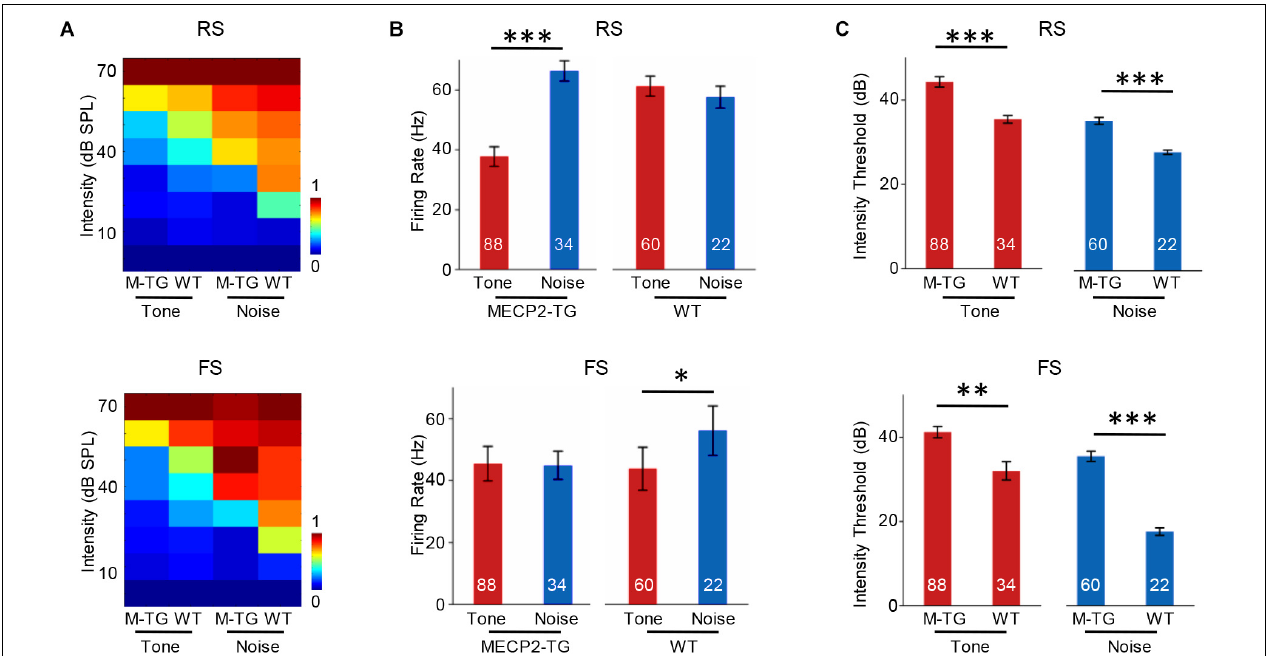
FIGURE 7 | (A) Average receptive fields of regular-spiking (RS) and fast-spiking (FS) neurons recorded from MECP2-TG and wild-type (WT) mice in response to a pure tone [7000 Hz, 70 dB sound pressure level (SPL)] and white noise (70 dB SPL). (B) Averaged activity of RS and FS neurons in response to a pure tone (7000 Hz, 70 dB SPL) and white noise (70 dB SPL) at 70 dB. ∗ p < 0.05, ∗∗∗ p < 0.001; paired t -test; mean ± SEM. (C) Average intensity threshold of RS and FS neurons recorded from MECP2-TG mice and WT mice to a pure tone and white noise. ∗∗ p < 0.01, ∗∗∗ p < 0.001, paired t -test, mean ± SEM (red: tone stimulus; blue: noise